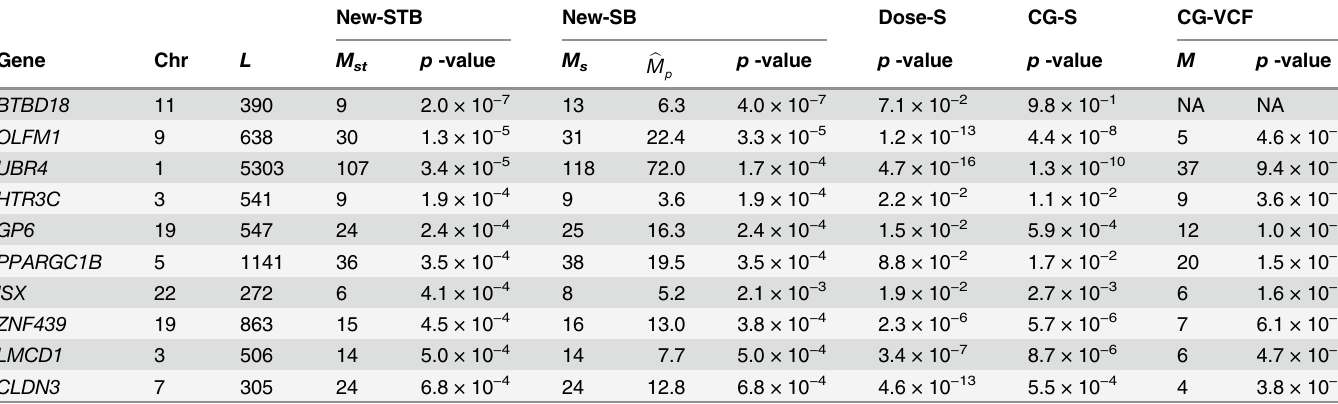
Chr is the chromosome number. L is the total number of loci (base pair) in the gene. M s is the number of loci that were screened in. M st is the number of loci that were screened in and passed the threshold. b M is the estimated number of SNVs. NA is not p